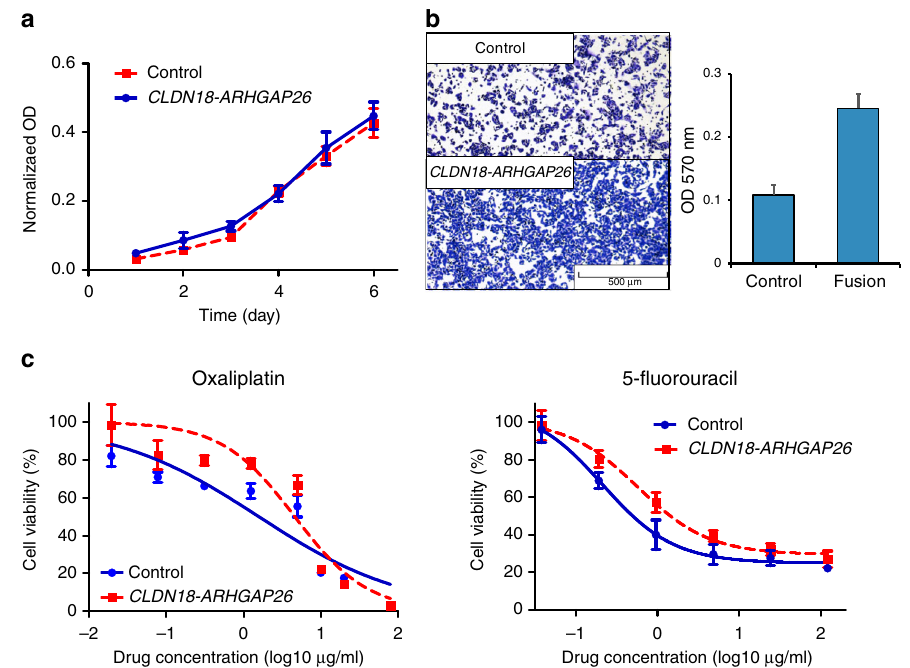
Fig. 6 Impact of CLDN18-ARHGAP26 overexpression in cell line. Cell proliferation ( a ), cell migration ( b ), and drug response to oxaliplatin/5- fl uorouracil ( c ) was estimated in CLDN18-ARHGAP26 stably expressed BGC-823 cells and its matched control. Each experiment has been replicated for three times, and data is presented as mean ± SD